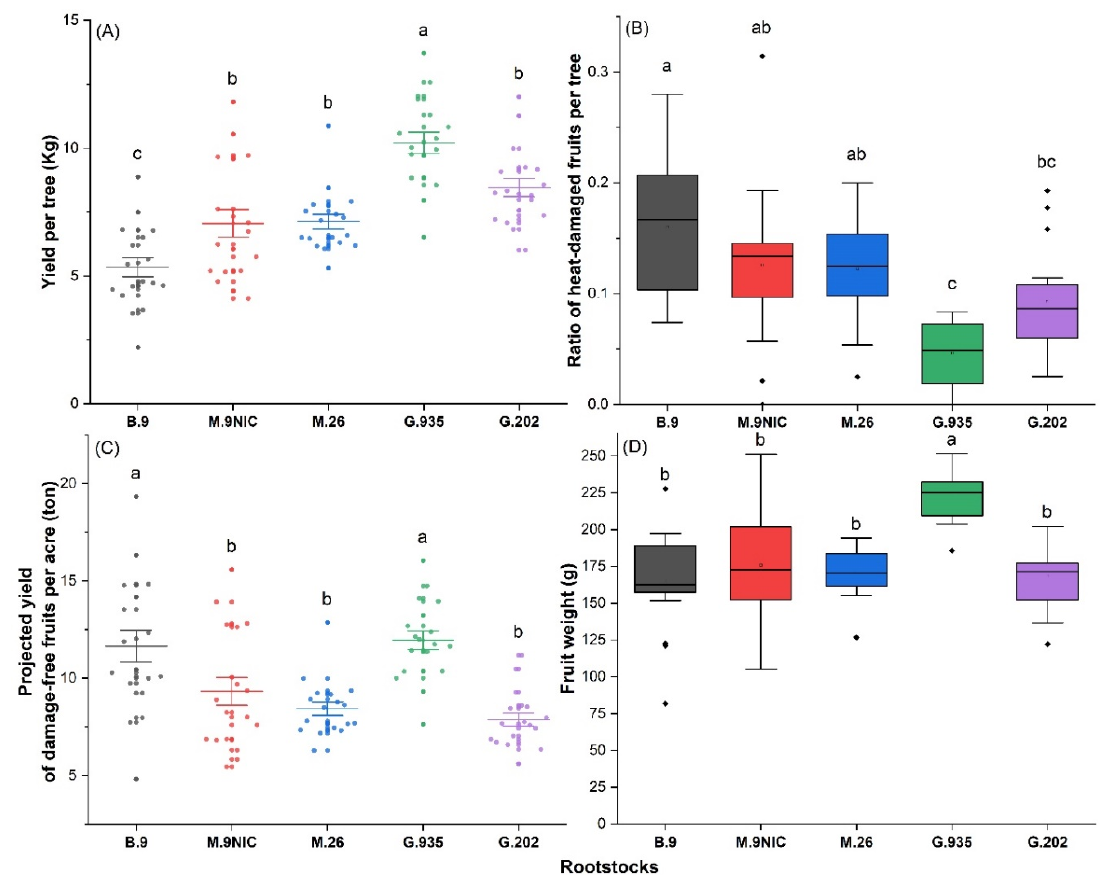
Figure 7. Yield ( A ), ratio of sunburn damaged fruits ( B ), projected damage-free yield per acre ( C ), and average fruit weight ( D ) of ‘Ambrosia’ apple on rootstocks B.9, M.9NIC29, M.26, G.202, and G.935 in 2021. In ( C ), yield was projected based on the estimated optimum tree counts per acre for each rootstock vigor class, i.e., 2180 trees for B.9, 1320 trees for M.9, 1180 trees for M.26 and G.935, and 930 trees for G.202. Different letters in each subpanel stand for statistical significances at p ≤ 0.05 (ANOVA, Tukey pairwise comparison).